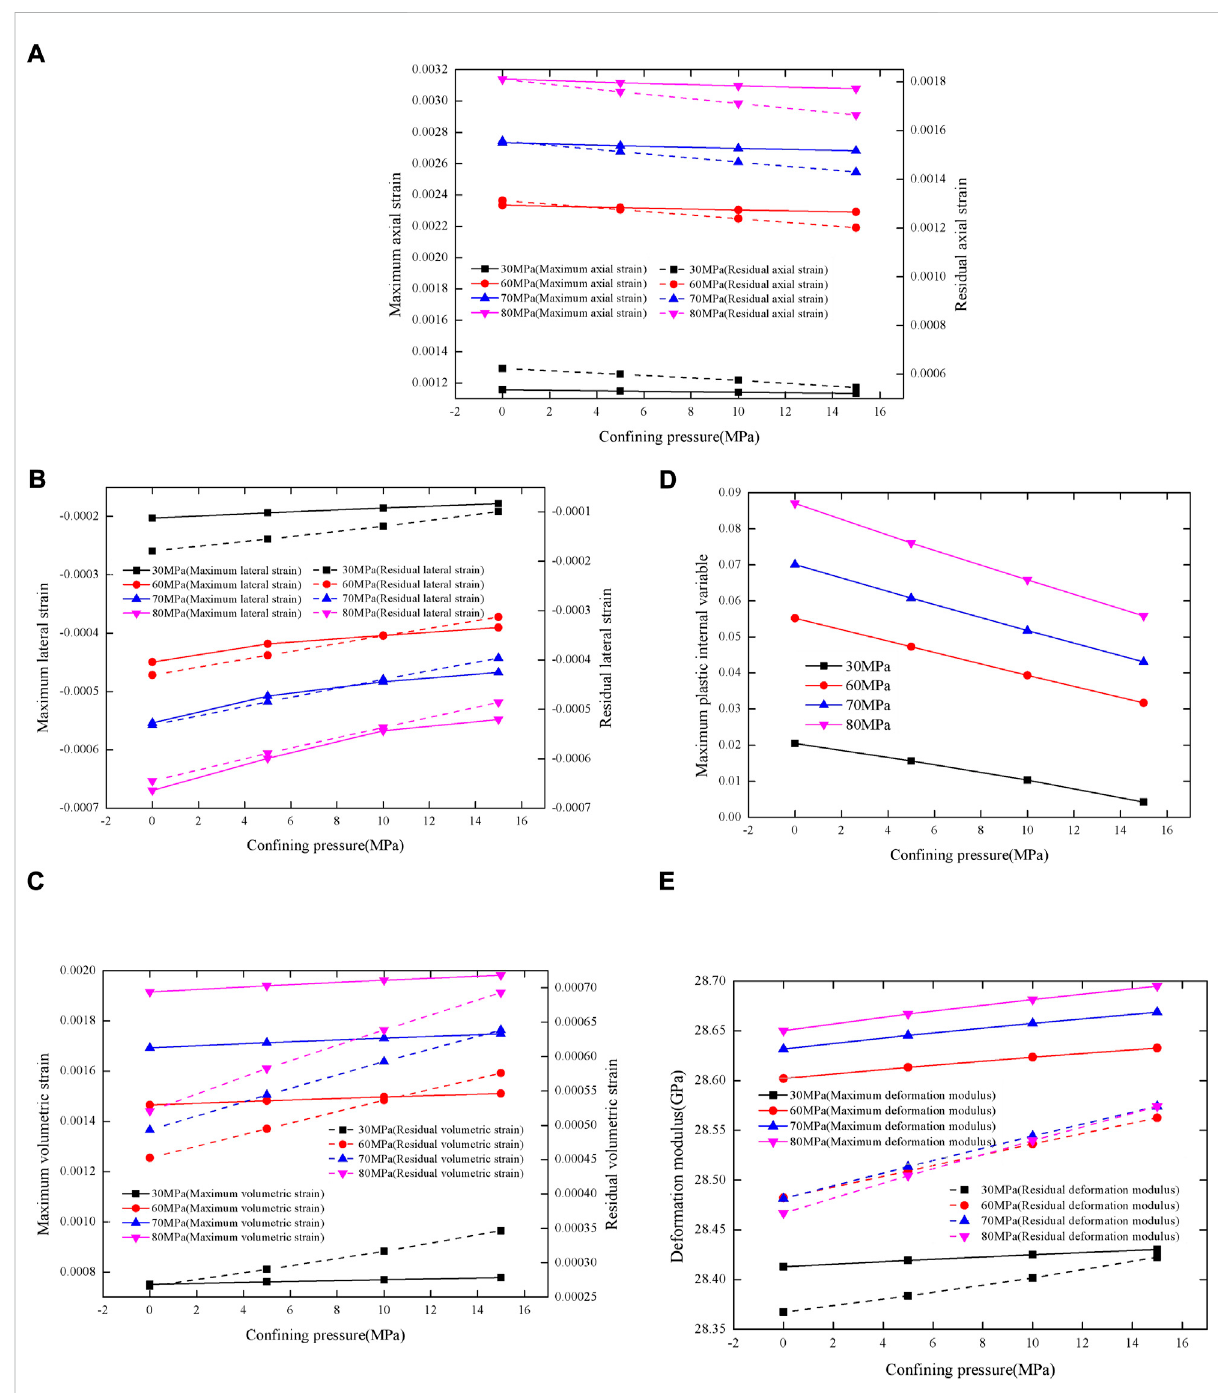
FIGURE 11 The variation in deformation properties of the rock with con fi ning pressure under Kobe seismic load with different maximum stresses: (A) Axial strain; (B) Lateral strain; (C) Volumetric strain; (D) Maximum plastic internal variable; (E) Deformation modulus.